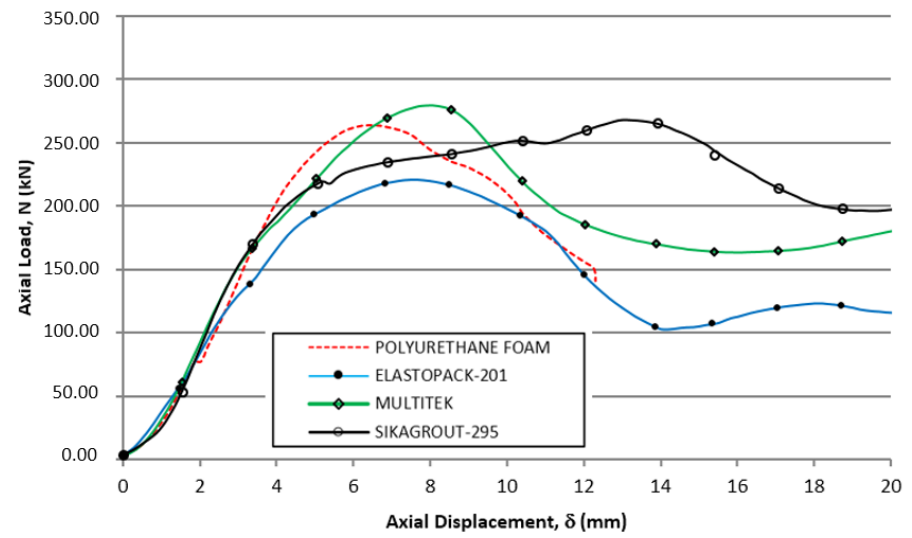
Figure 6. Load-displacement curves of the elements in the first load cycle (abscissa: origin—20 mm), from the beginning of the test until the elements are unloaded after the first maximum load.